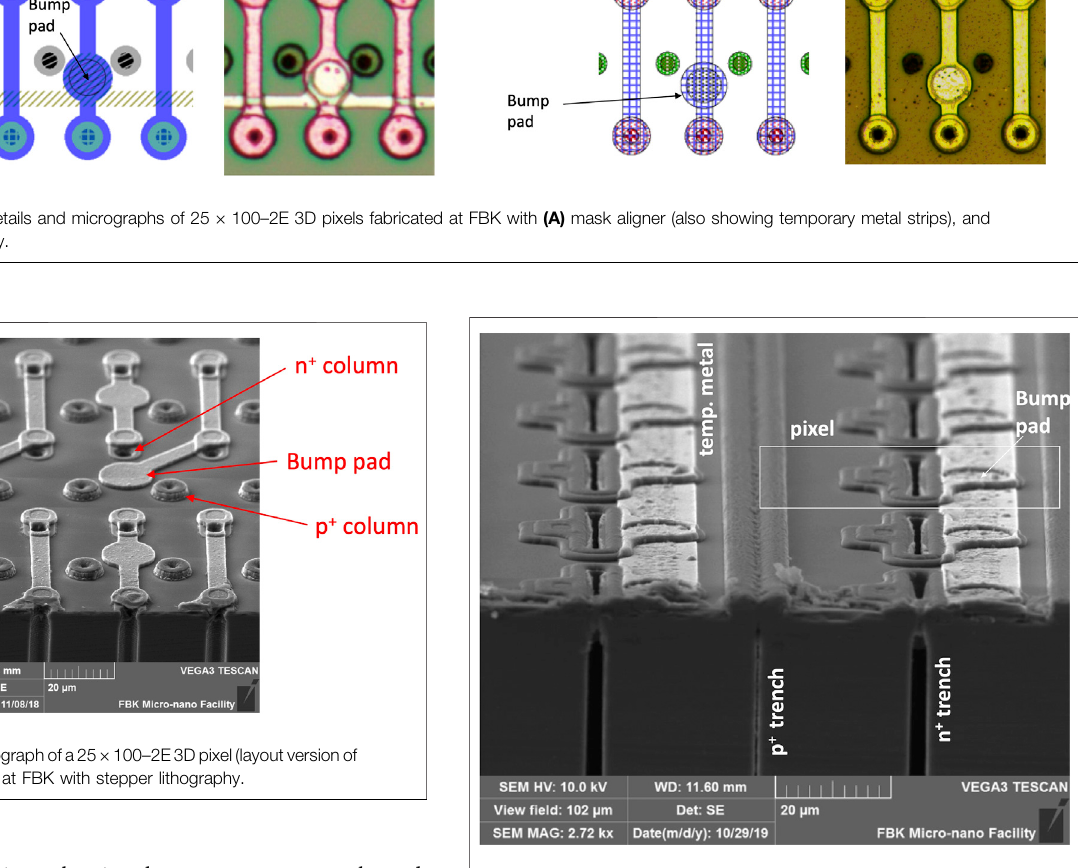
FIGURE 9 | SEM micrograph of a group of trenched 3D pixels (see layout in Figure 4 ) from the fi rst batch fabricated at FBK with stepper